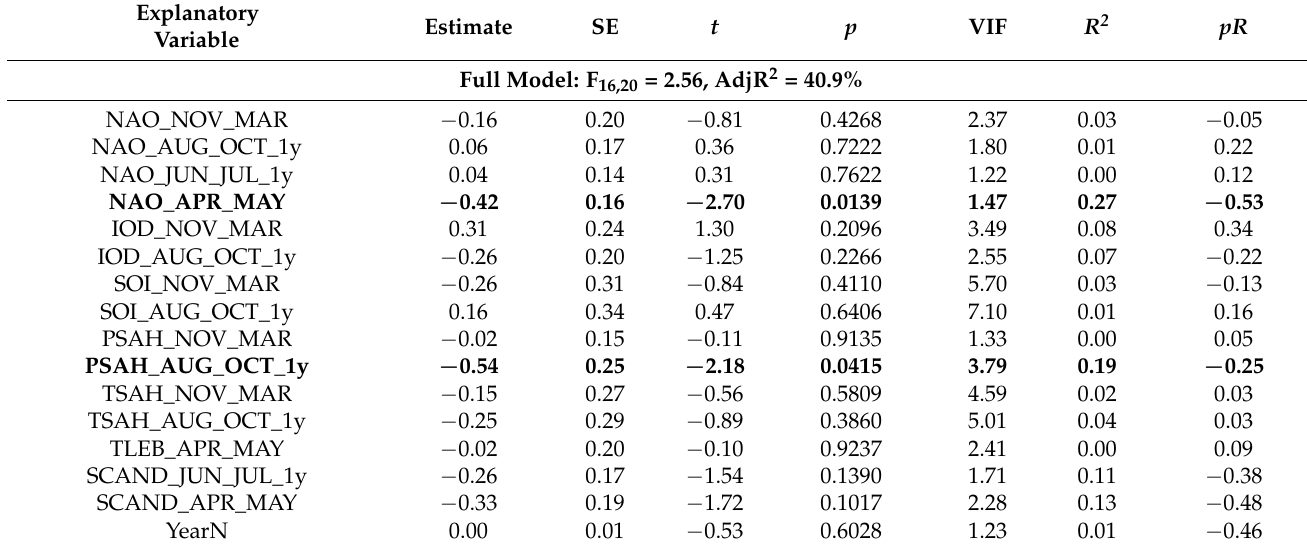
Table A5. Relationships between 15 climate variables and year in full models and Annual Anomaly of the timing of spring migration for the Blackcap Sylvia atricapilla caught at Bukowo, Poland, in 1982–2021. Estimate—coefficients from multiple regression, SE—standard error of the estimates; t , p — t -test and significance of each estimate, p < 0.05 marked in bold face. VIF—variance inflation factor. R 2 —partial determination coefficients, pR —Pearson’s partial correlation coefficient.